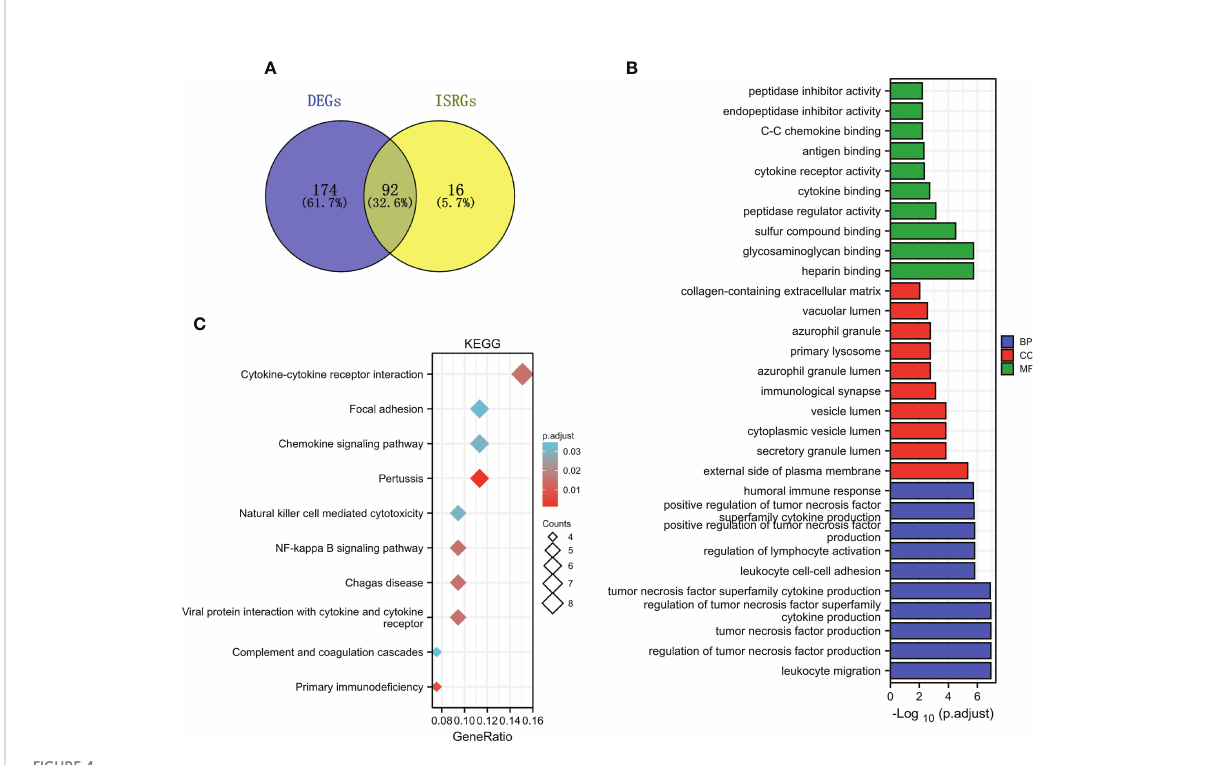
FIGURE 4 Functional enrichment analysis of ISRDEGs. (A) The Venn diagram shows the interaction between DEGs and ISRGs. GO (B) and KEGG (C) enrichment analyses for the 92